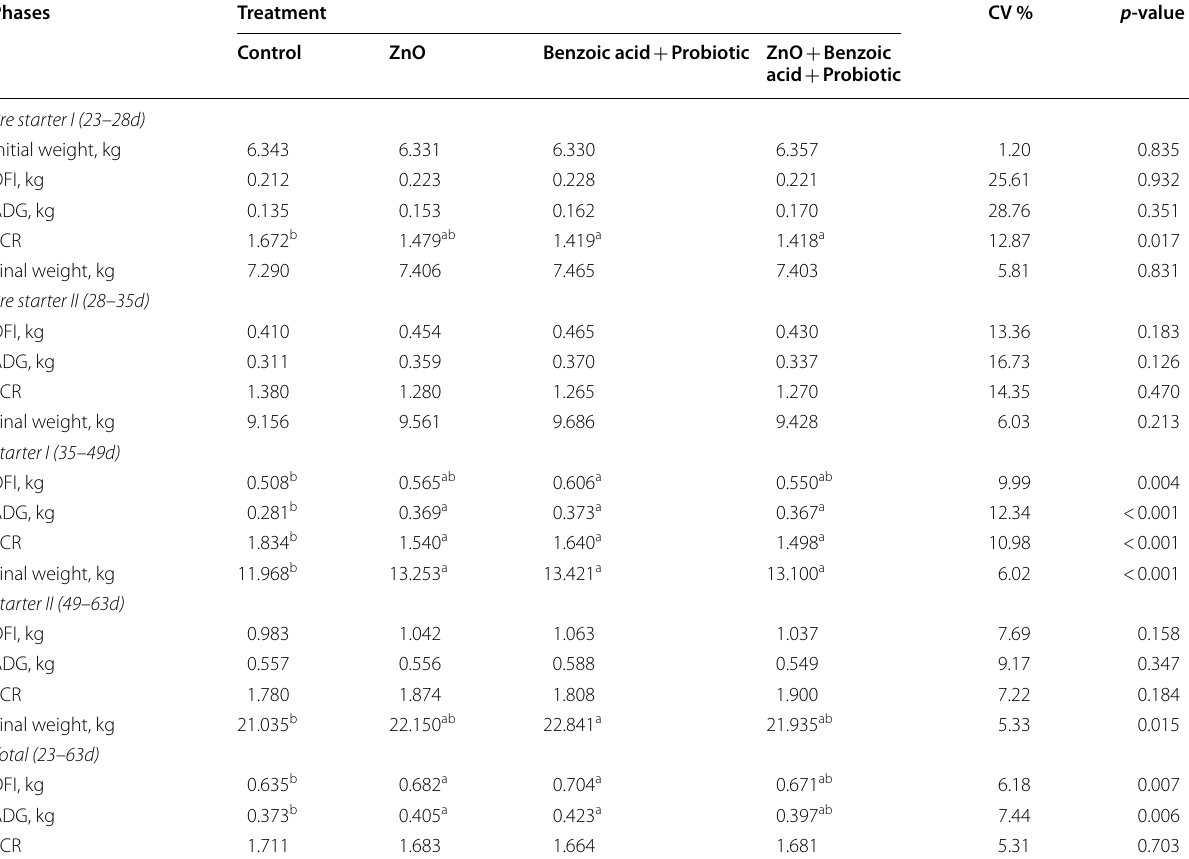
P) and ZnO BA P according the phases + + +